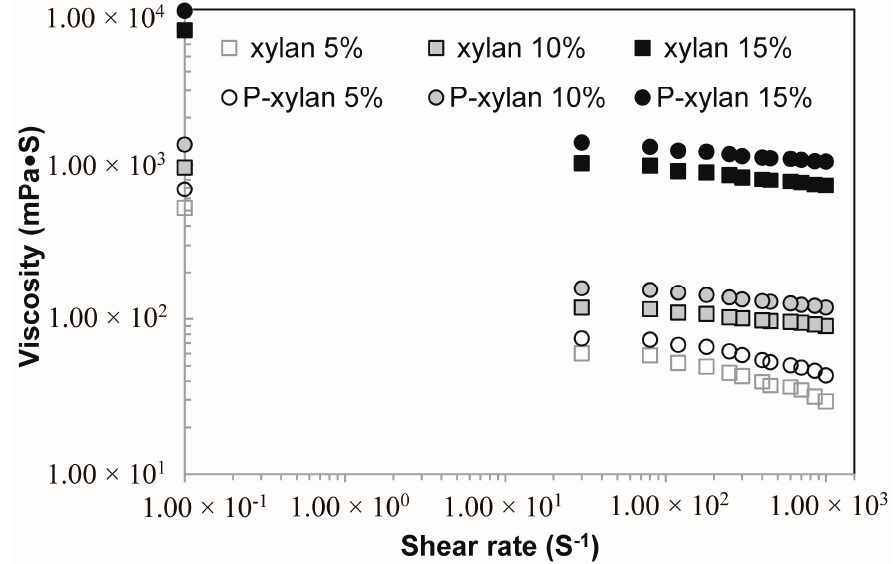
Figure 8. Viscosity of xylan and phosphorylated xylan (P-xylan) solutions as function of shear rate at various concentration.